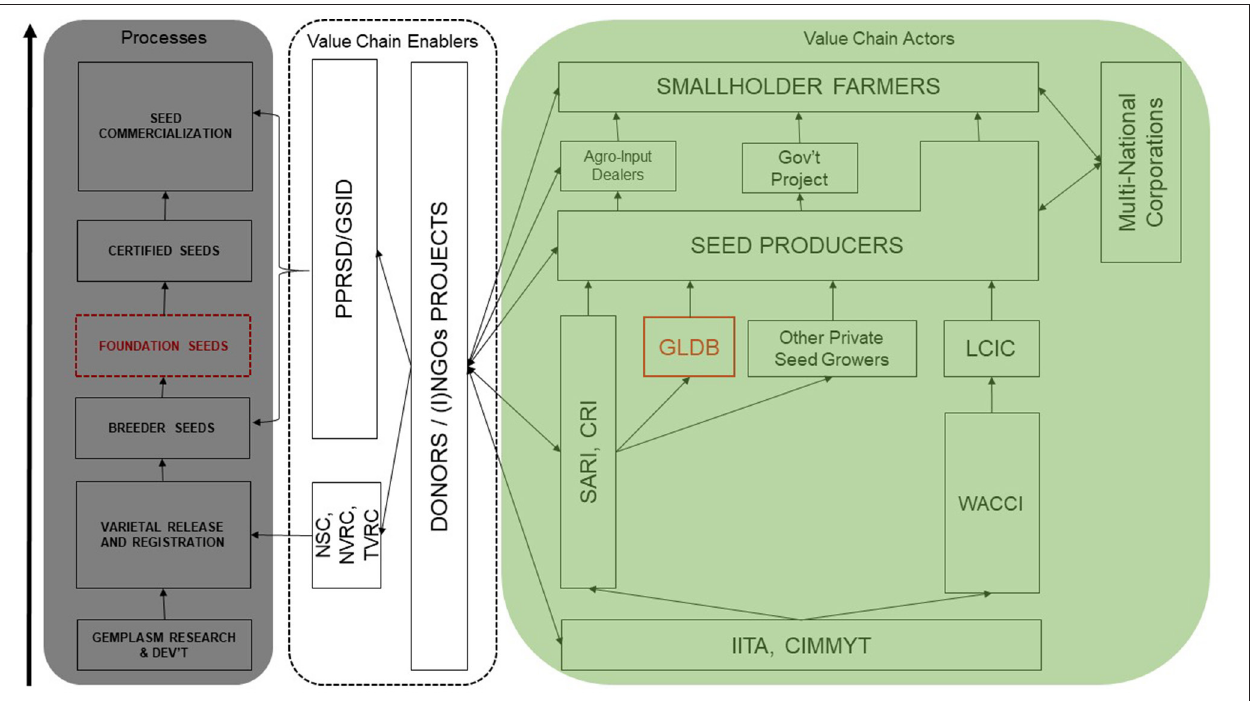
FIGURE 2 | Structure of the formal maize seed value chain in